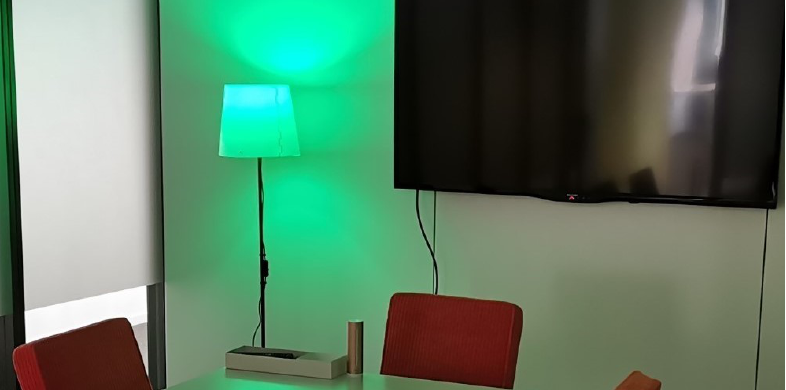
Figure 9. A colored light showing the real-time COVID-19 aerosol transmission risk estimation status in a meeting